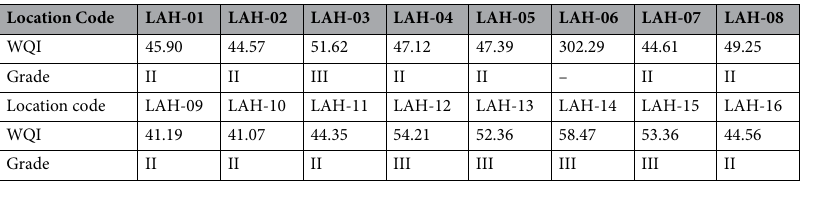
Table 11. Water quality index